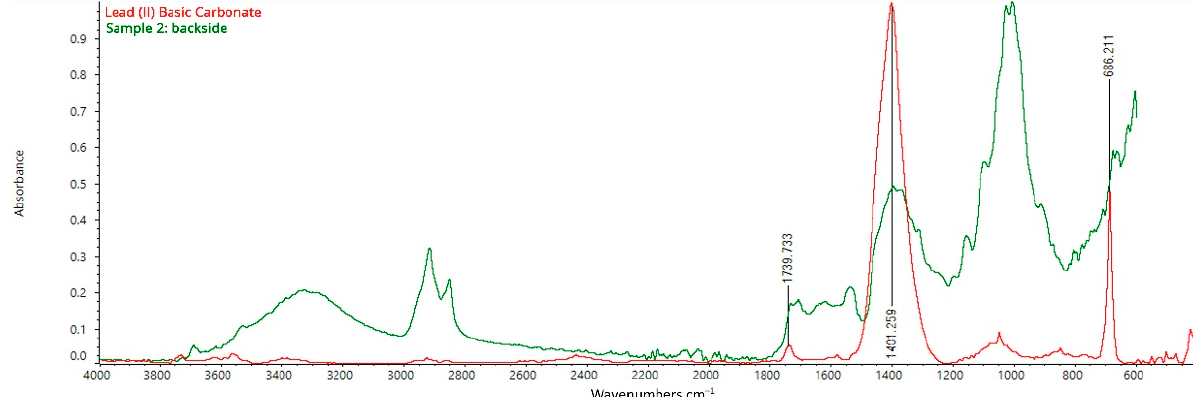
Figure 10. FT-IR ATR spectrum acquired on the backside of sample 2, consisting of the original canvas, the preparation layer, the primer, and the paint layers: analysis of the backside of the canvas. Once again, spectra collected by placing both the preparation layer and the top layer of samples n. 1 and 2 on the ATR diamond show bands attributable to Lead (II) Basic Carbonate (Lead White) and metal soaps constituting the paint layer (Figure 11) [32–35]. The peak at 1542 cm − 1 is related to the asymmetrical stretching vibrations of COO − [36]. It can be attributed to the presence of metal soaps in the layer, which could either have been intentionally used as additives to modify the physical properties of the painting materials or be the result of chemical reactions between metal ions constituting the pigments and free fatty acids from lipidic binders (in this case, oil) [37–40]. In addition, the characteristic absorption band at 3565–3530 cm − 1 is attributed to the vibrational motions of –O–H confirming the detection of both lead carbonate and linseed oil. The bands at 2960, 2855, and 1739 cm − 1 are assigned to the vibrational asymmetrical stretching of –C–H 2 , vibrational symmetrical stretching of –C–H 2 , and –C=O of the triglyceride cross-linked network characteristic of siccative oils.